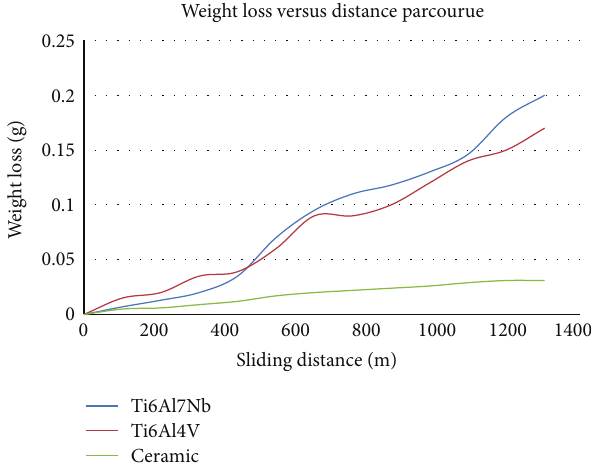
Figure 8: Weight loss of Ti alloys during wear sliding against abrasive paper.